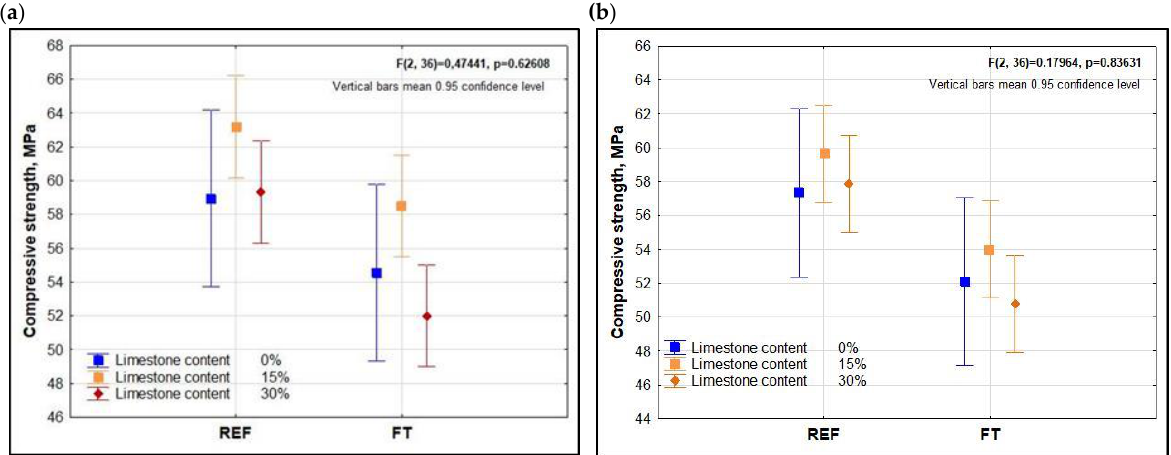
Figure 17. ANOVA analysis of the effect of limestone content on the compressive strength of refer- ence concrete (REF) and concrete after 200 cycles of freeze – thaw (FT) for ( a ) vibrated concretes, ( b ) SCC. concrete (REF) and concrete after 200 cycles of freeze–thaw (FT) for ( a ) vibrated concretes, ( b )